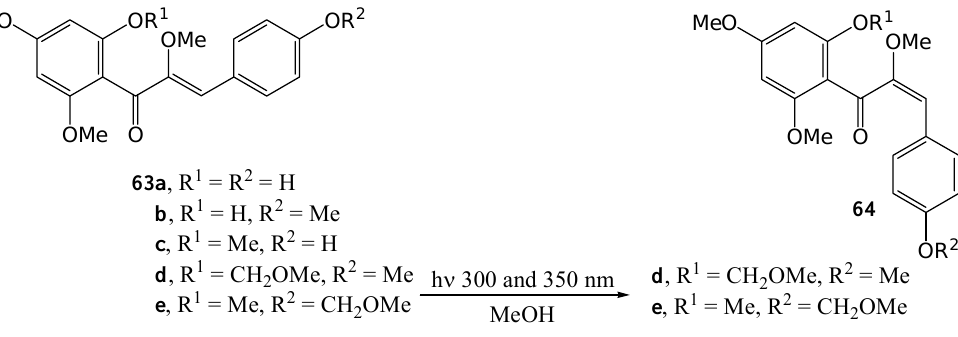
OMeOR 1 OMeO OMe 64f , R 1 = Me, R 2 = H g , R 1 = H, R 2 = OR 2